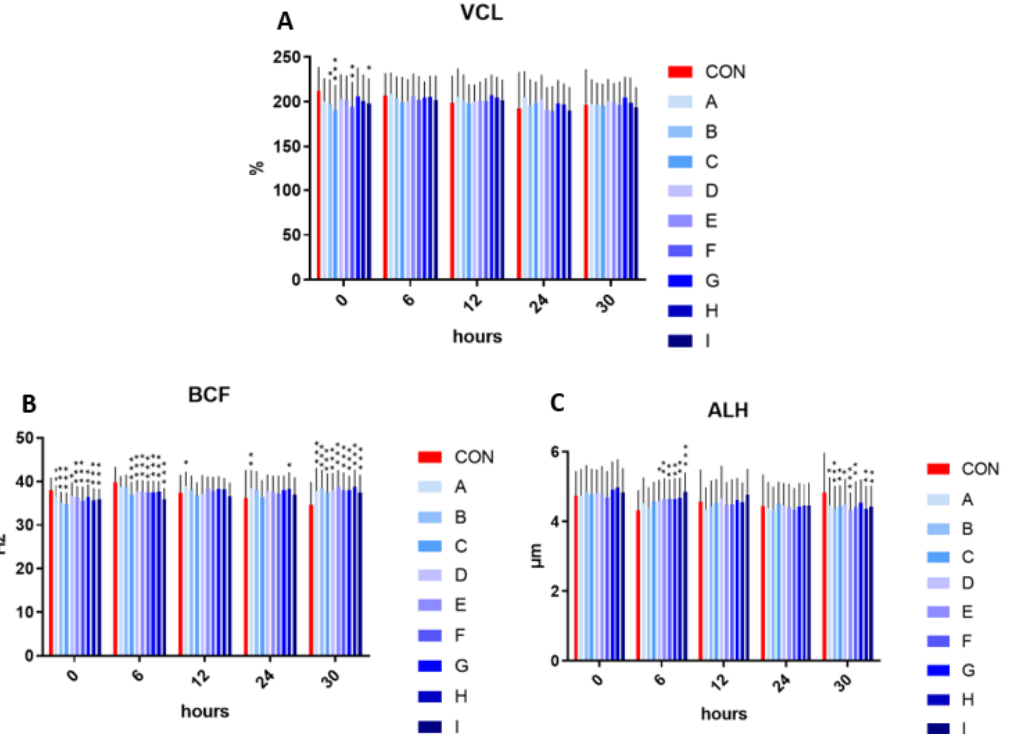
Figure 2. ( A ) The effect of taurine and caffeine on the velocity curved line (µm/s) at 5 °C ( n = 10). ( B ) The effect of taurine and caffeine on the beat cross frequency (Hz) at 5 °C. ( C ) The effect of taurine and caffeine on the amplitude of spermatozoa lateral head displacement (µm) at 5 °C. CON: 0 mg/mL taurine + 0 mg/mL caffeine; A: 2.5 mg/mL taurine + 0.625 mg/mL caffeine; B: 2.5 mg/mL taurine + 1.25 mg/mL caffeine; C: 2.5 mg/mL taurine + 2.5 mg/mL caffeine; D: 5 mg/mL taurine + 0.625 mg/mL caffeine; E: 5 mg/mL taurine + 1.25 mg/mL caffeine; F: 5 mg/mL taurine + 2.5 mg/mL caffeine; G: 7.5 mg/mL taurine + 0.625 mg/mL caffeine; H: 7.5 mg/mL taurine + 1.25 mg/mL caffeine; I: 7.5 mg/mL taurine + 2.5 mg/mL caffeine. Each bar represents the mean value of observed samples (±SD). The level of significance was set at *** ( p < 0.001), ** ( p < 0.01) and * ( p < 0.05).